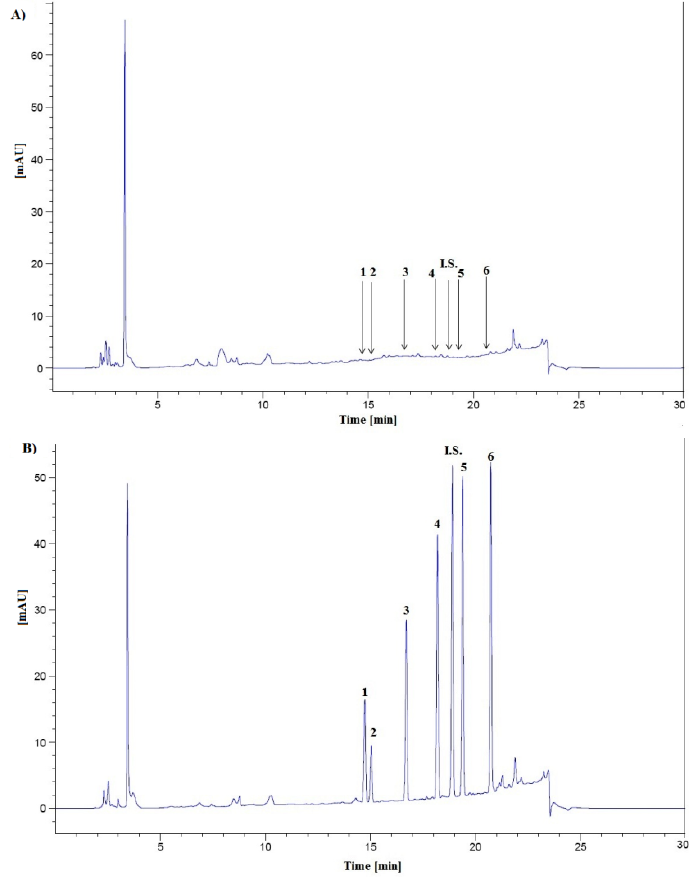
Figure 2. Typical chromatograms of blank human urine extract ( A ) and urine sample spiked with cortisone ( 1 ); cortisol ( 2 ); corticosterone ( 3 ); testosterone ( 4 ); epitestosterone ( 5 ); progesterone ( 6 ), each analyte at a level of 100 ng mL − 1 and methyltestosterone (I.S.) at a concentration of 100 ng mL − 1 ( B